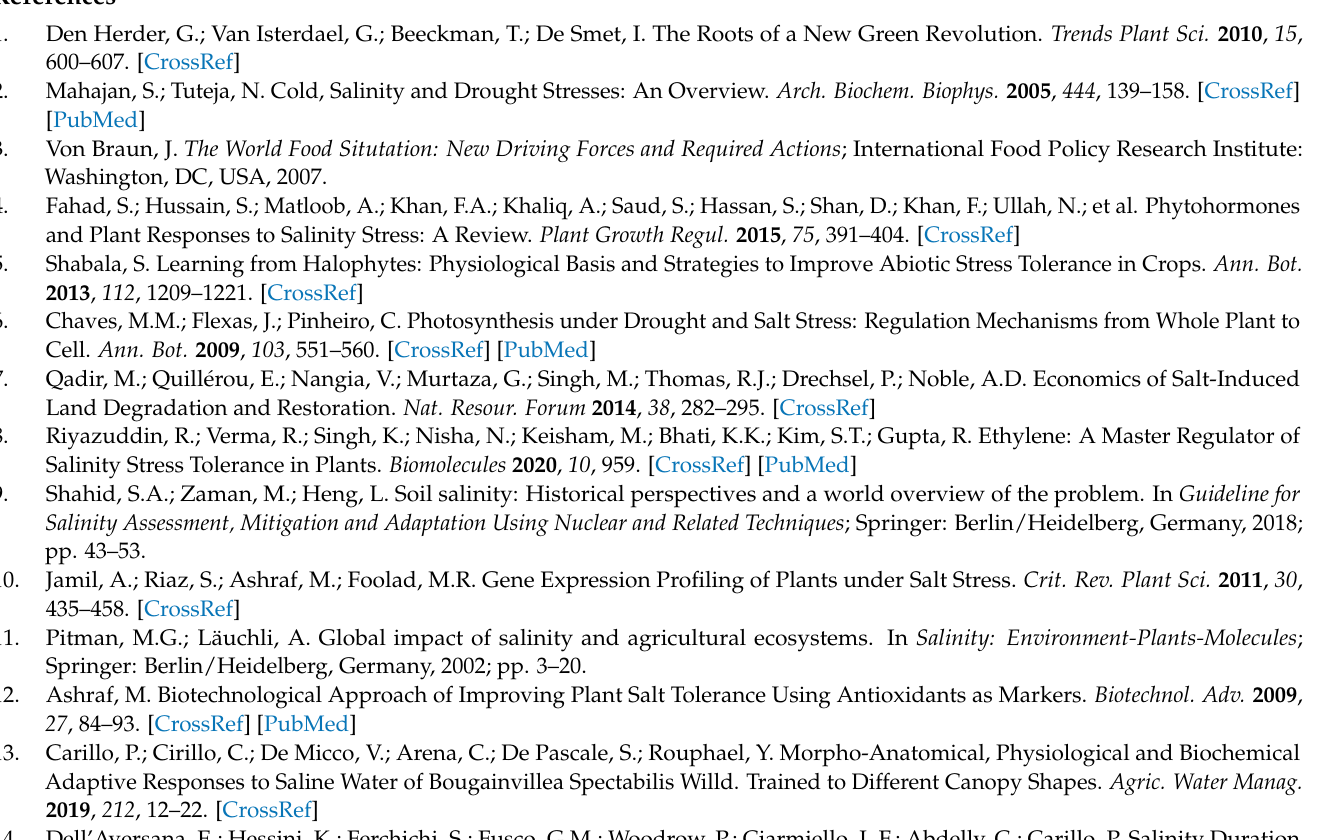
Table S2. Genes that are part of the classical antioxidant system, and predominantly involved in H 2 O 2 detoxification were not differentially expressed [117]. Table S3. Comparative differential expression of Peroxidases and Glutathione S-transferases with and without salt stress (control) upon Cu-chl application. Table S4. Comparative differential expression of abiotic stress responsive Transcription factors with and without salt stress (control) upon Cu-chl application. Table S5. Sequences of primers used in the